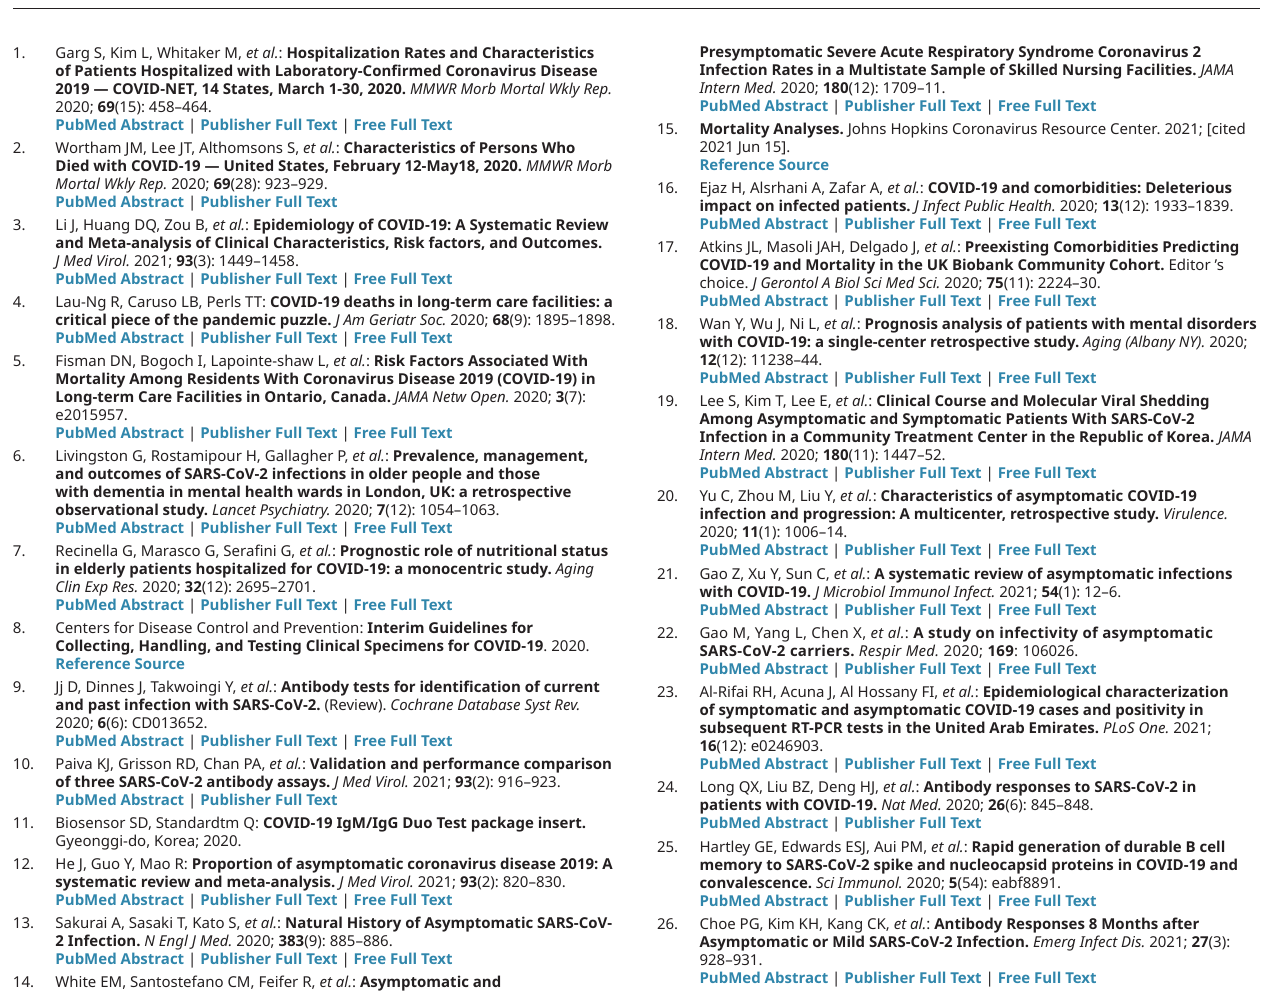
Figshare. “Asymptomatic COVID-19 in the elderly: dementia and viral clearance as risk factors for disease progression”.